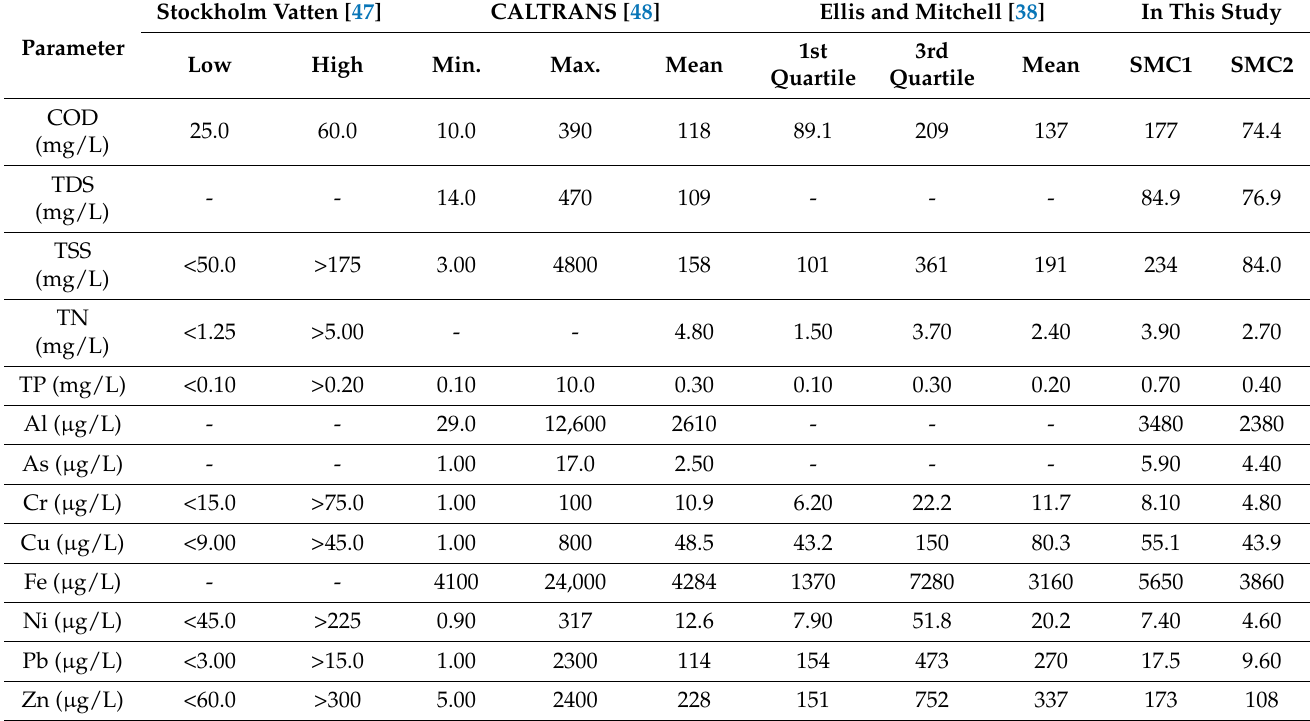
Table 3. Comparison of concentrations observed in road runoff with reference